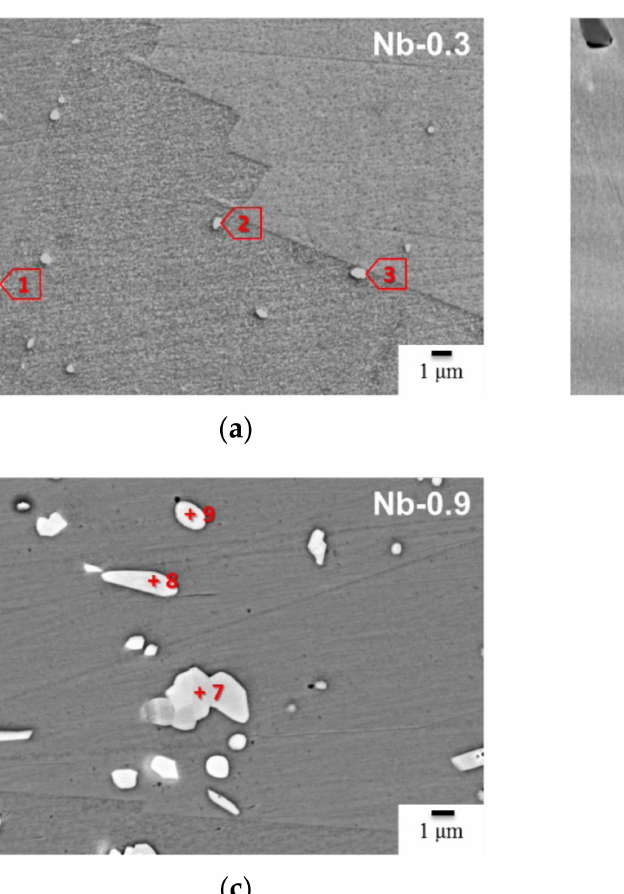
Figure 4. Microstructure and precipitate morphology of the 22Cr25NiWCuCo(Nb) steel specimens after heat treatment at 1200 ◦ C for 6 h: ( a ) Nb-0.3, ( b ) Nb-0.6, and ( c ) Nb-0.9 steel specimens. (Marked points 1–9 is the chemical composition analysis which corresponding to Table 3.) Table 3. EPMA/WDX analysis of different phases in the 22Cr25NiWCuCo(Nb) steel specimens after heat treatment at 1200 ◦ C for 6 h (for the marked points in Figure 4). Cr at.%